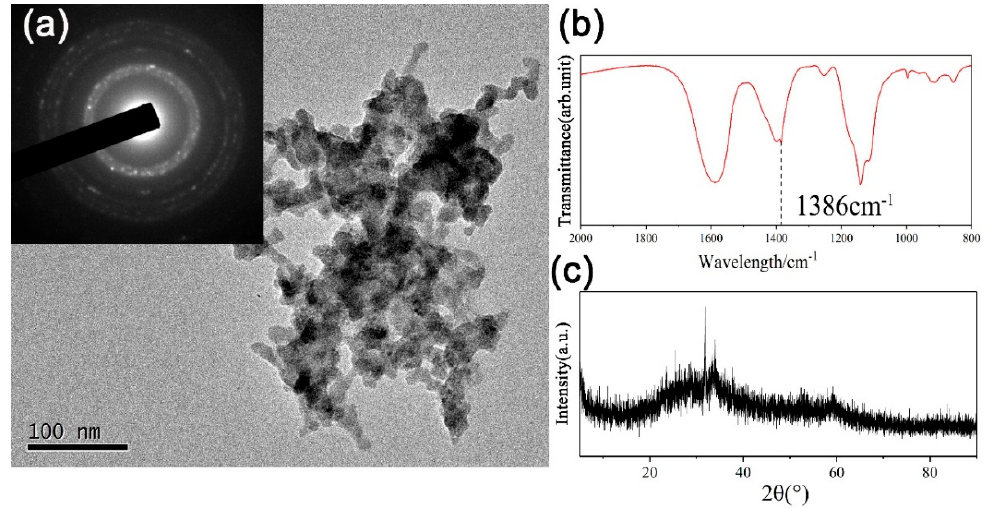
Figure 5. XRD pattern of the strip precursor taken at 20 min in OS route.